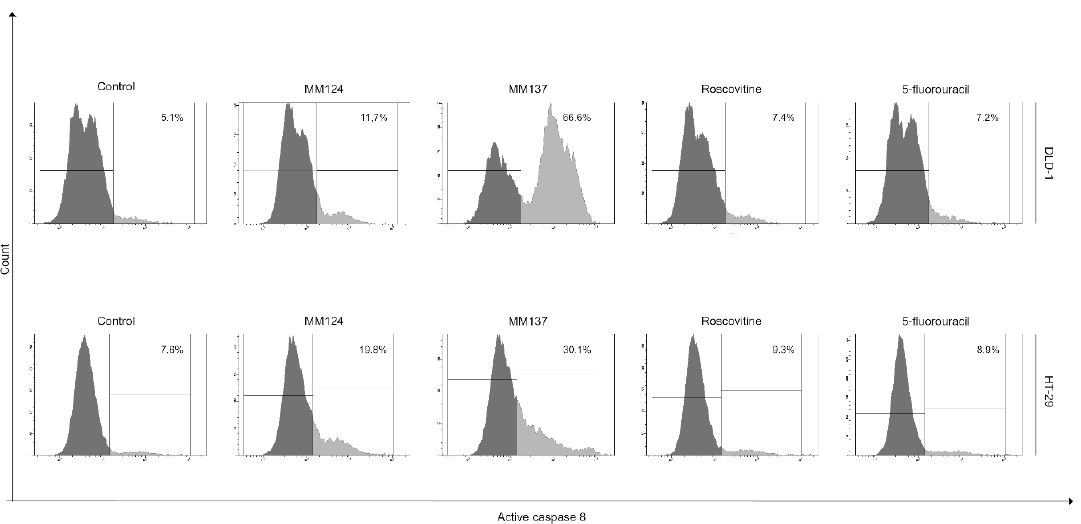
Figure 6. Flow cytometric detection of active caspase-8 in HT-29 and DLD-1 human colorectal cancer cells treated for 24 h with novel 7-methyl-5-phenyl-pyrazolo[4,3- e ]tetrazolo[4,5- b ][1,2,4]triazine sulfonamide derivatives (MM124, MM137), 5-fluorouracil, and roscovitine at 0.5 µM concentration. Mean percentage values from three independent experiments done in duplicate are presented.